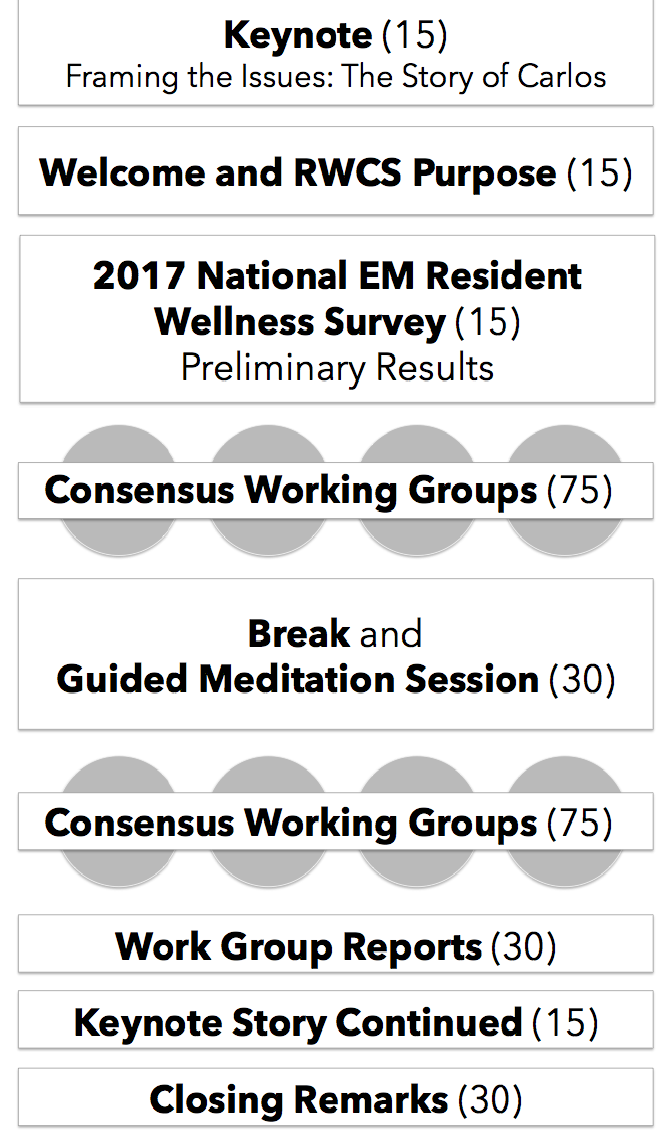
Figure. Segmented timeline of Resident Wellness Consensus Summit event and allotted time for each segment in parentheses